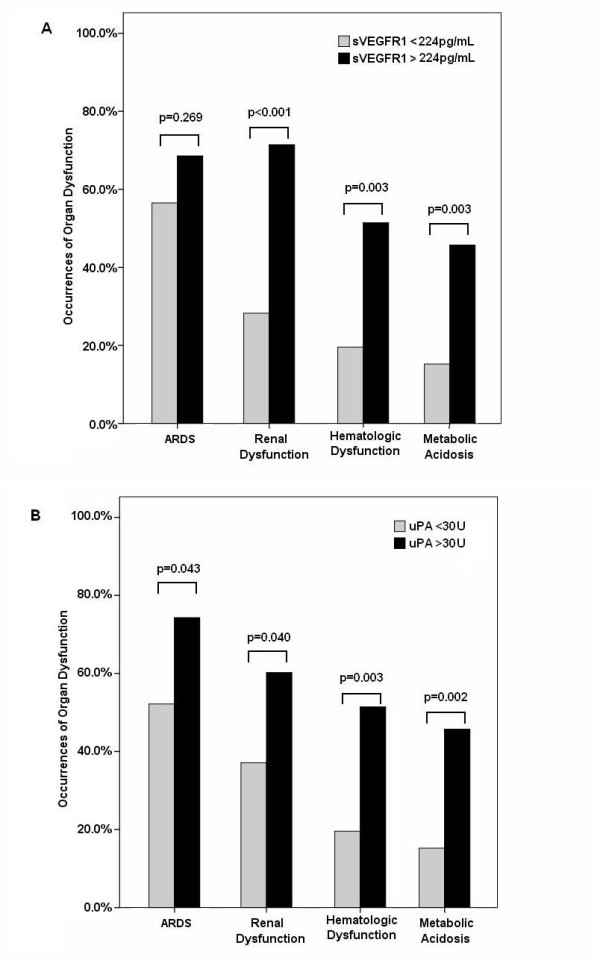
Organ dysfunctions in patients with pneumonia-related septic shock. The occurrence of organ dysfunction at the onset of septic shock was compared based on plasma (a) soluble vascular endothelial growth factor receptor 1 (sVEGFR1) levels and (b) urokinase plasminogen activator (uPA) activities above the optimal cutoff points (solid bars) and below the optimal cutoff points (shaded bars). Significance was tested by Pearson's chi-square test. ARDS, acute respiratory distress syndrome.